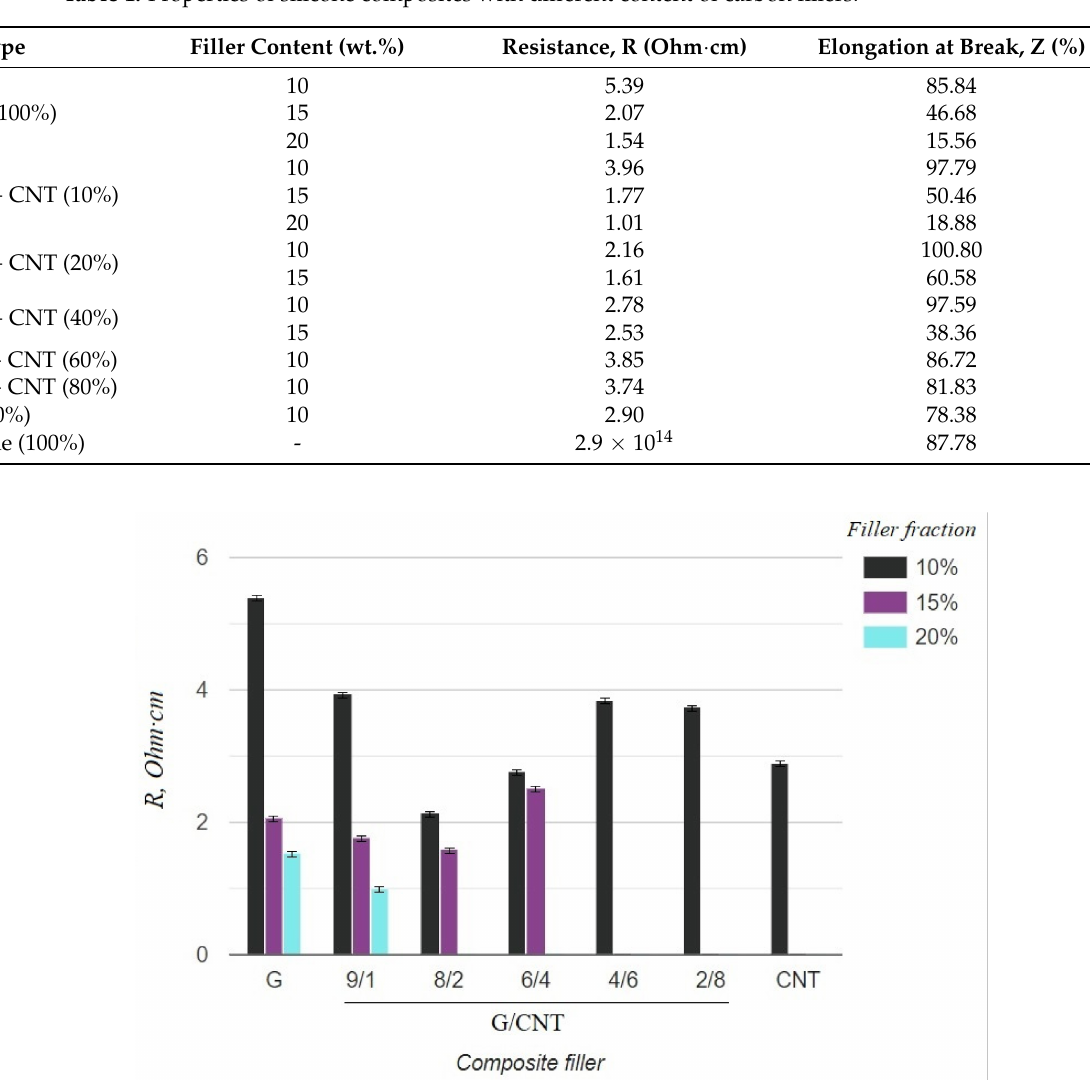
Table 1. Properties of silicone composites with different content of carbon fillers.